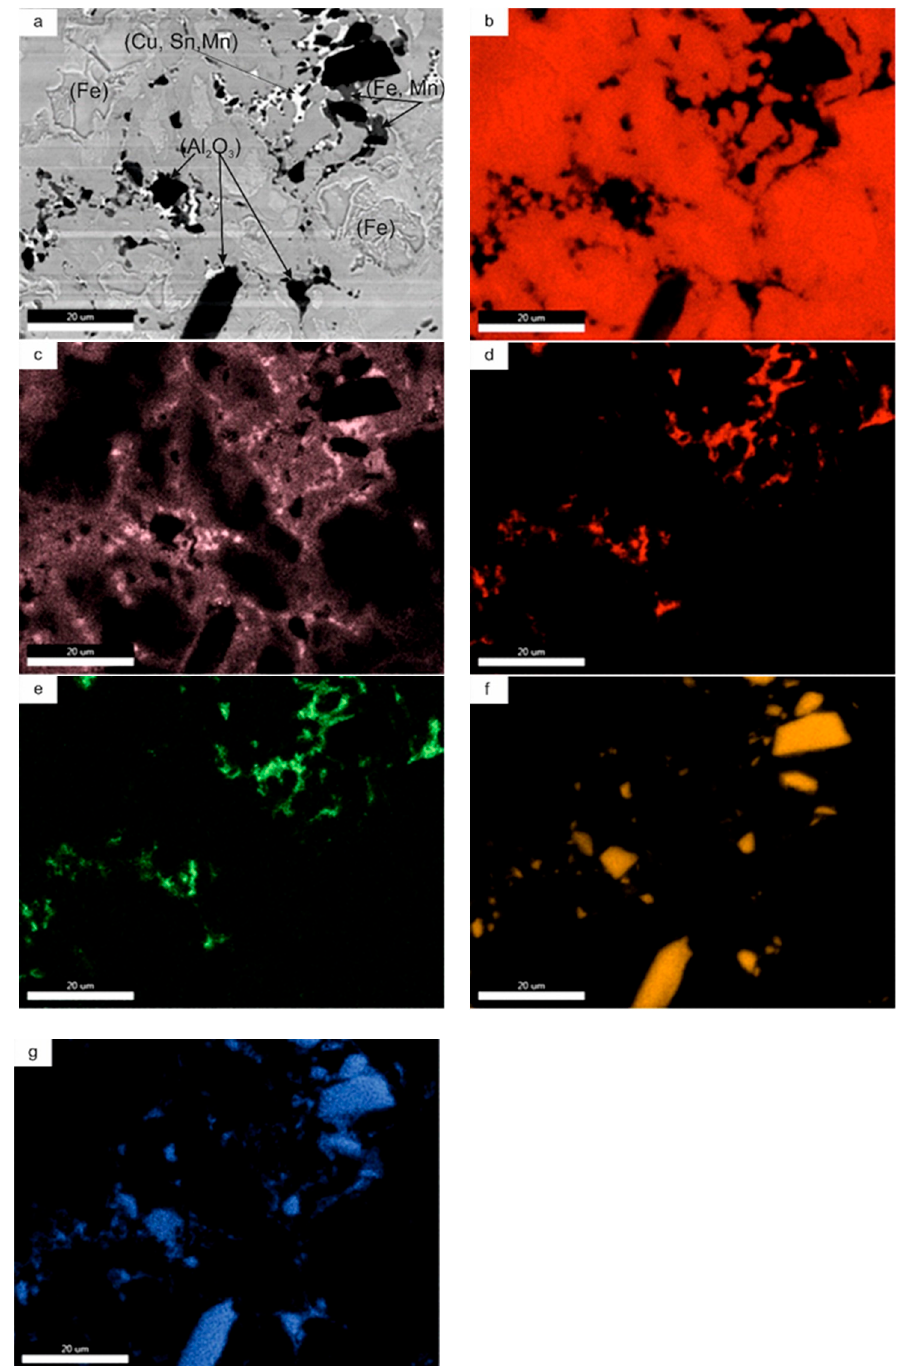
Figure 7. SEM image of ( a ) Base + 10% Al 2 O 3 composite. EDS maps of: ( b ) Fe; ( c ) Mn; ( d ) Cu; ( e ) Sn; ( f ) Al; ( g ) O.